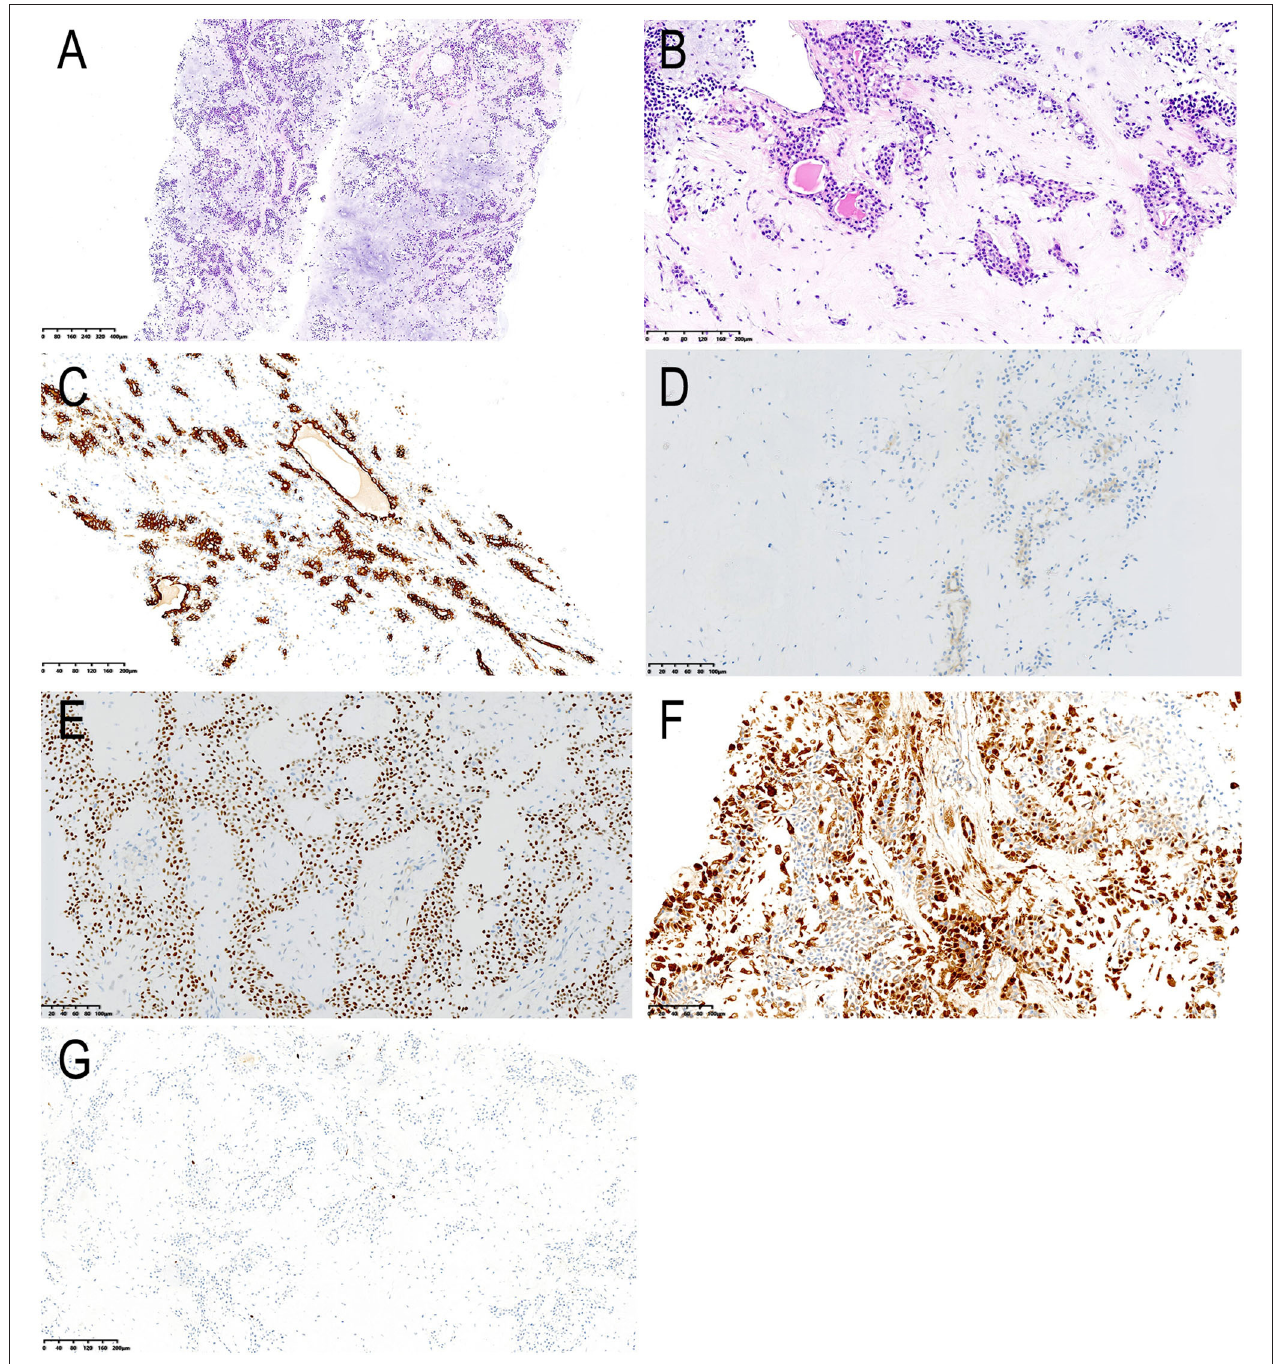
FIGURE 3 | Histological and immunohistochemical features. (A,B) Haematoxylin-eosin (HE) staining showing ductal cells, myoepithelial cells and prominent chondromyxoid matrix background. The cuboidal ductal epithelium forms a glandular tubular structure, with red secretion in the lumen; the myoepithelial cells surround the glandular tubular structure or are scattered across the chondromyxoid matrix; the cellular atypia is not obvious (magnification, A × 50, B × 200). By immunohistochemistry, the ductal cells are strongly positive for CK7 (C) and positive for CD117 (D) , while myoepithelial cells are positive for p63 (E) and S-100 (F) . Less than 1 % cells were positive for Ki-67 (G) . The final diagnosis was pleomorphic adenoma [magnification, (C–F) × 200, G ×